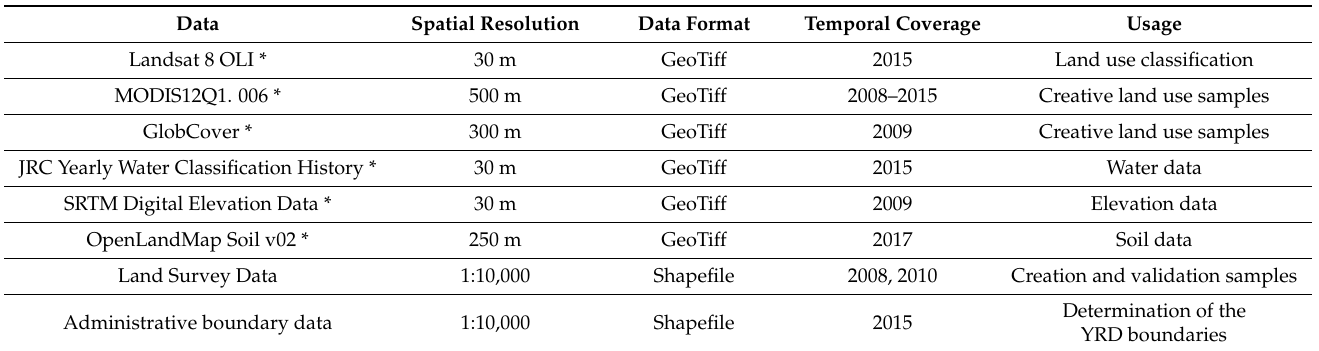
Table 1. Datasets used in this